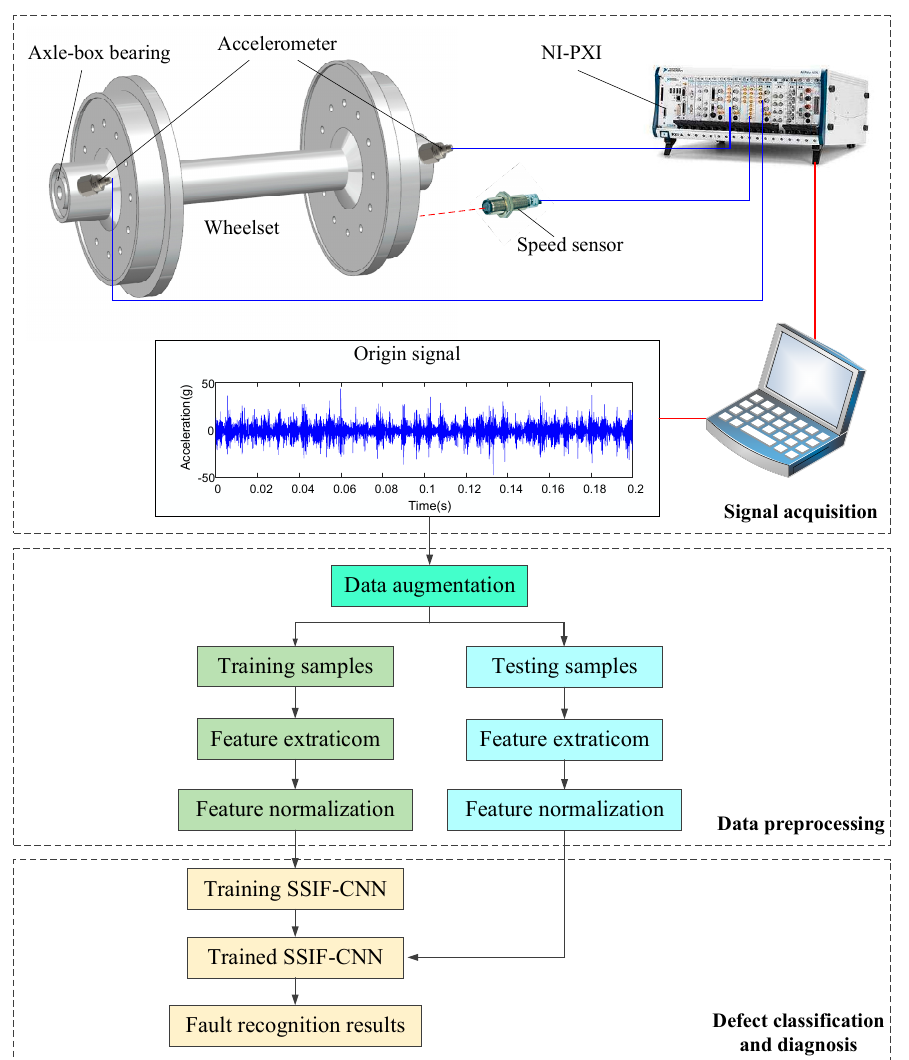
Figure 4. The fault diagnostic process follows the procedure of data acquisition, feature extraction, model training and fault classification.